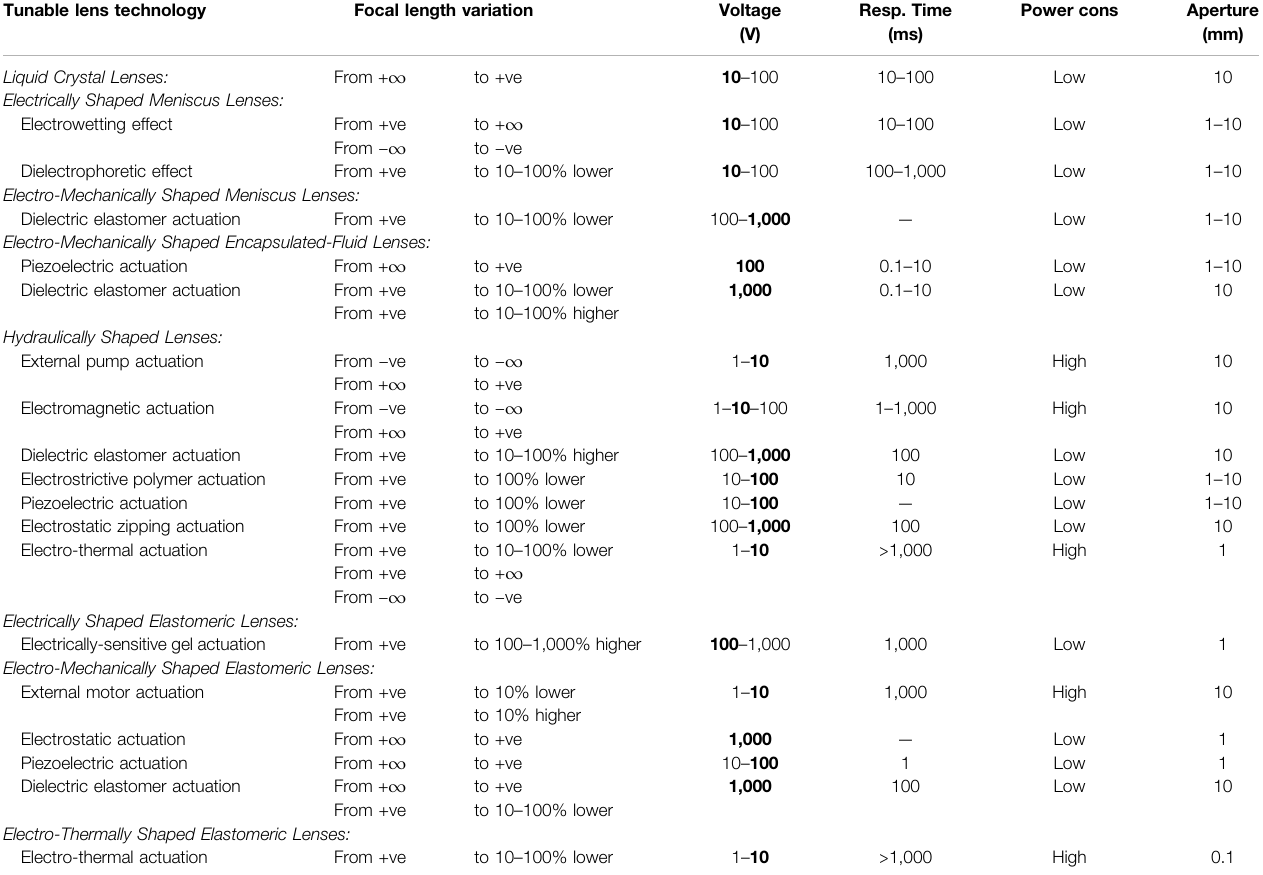
TABLE 1 | Comparison of the considered types of lenses. Each metric (except for the power consumption) is quanti fi ed in terms of orders of magnitude of typical values (abbreviations:+ve (cid:2) positive; − ve (cid:2) negative).Foreachlens,themosttypicalorderofmagnitudeofthedrivingvoltageisemphasized inbold.Thepowerconsumptionis expressed qualitatively, as information published in different studies is often not